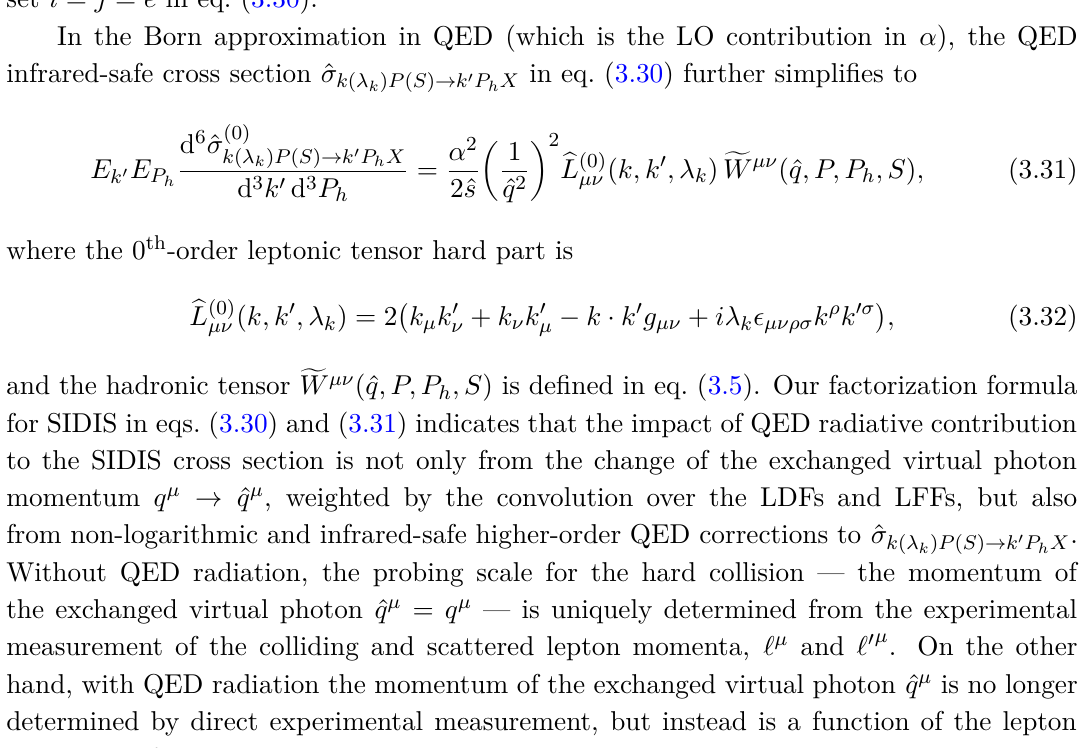
Figure 18 . Sketch for the “photon-hadron frame” for SIDIS according to the Trento convention [20]. where the integration limits ζ and ξ are given in eq. (2.24), and ˆ σ is min min k ( λ k ) P ( S ) → k 0 P h X infrared-safe as m → 0 , with all infrared sensitive collinear QED radiative contributions to e the cross section resummed into the LDFs and LFFs. (For ease of notation the dependence on the factorization scale in (3.30) is suppressed.) With the one-photon approximation, we set i = j = e in eq.